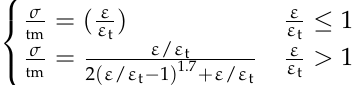
tensile uniaxial constitutive model is defined by “YULRX” five ‐ fold linear skeleton curve. The corresponding positions of the five key points are marked in Figure 12. In Perform ‐ 3D, the Limit States function is used to define the limit state value of tensile deformation of masonry (tension strain limit: ε = 0.000157), which means that the wall will be subject to tensile failure when the strain of masonry material exceeds this limit.